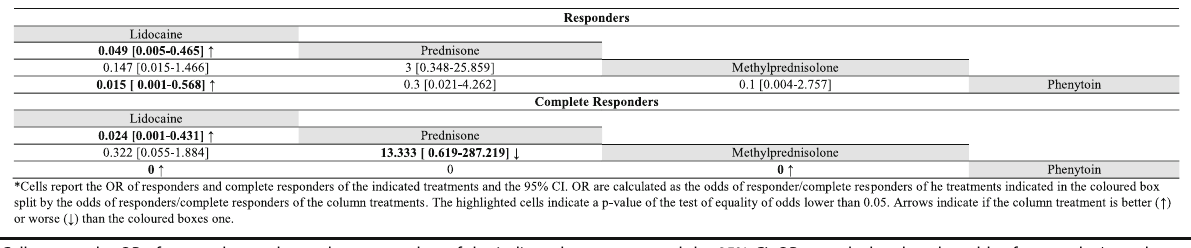
Table 6 statistical comparisons between the odds of responders and complete responders of acute treatment for SUNCT and SUNA*